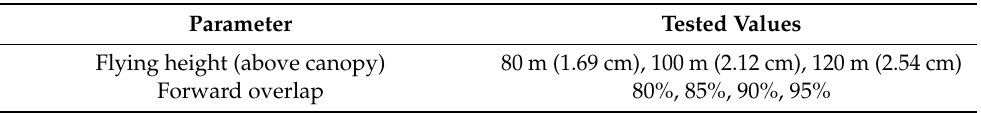
Table 1. Flying parameters tested in this study. The value in parenthesis is the nominal spatial resolution for that height given by senseFly eMotion Software.